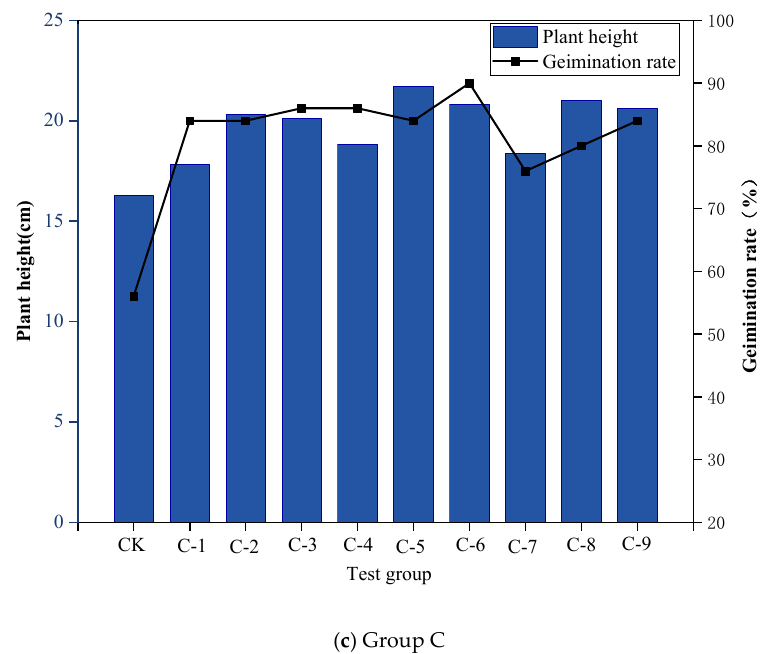
Figure 4. Result of the plant growth test with polymer composite material.